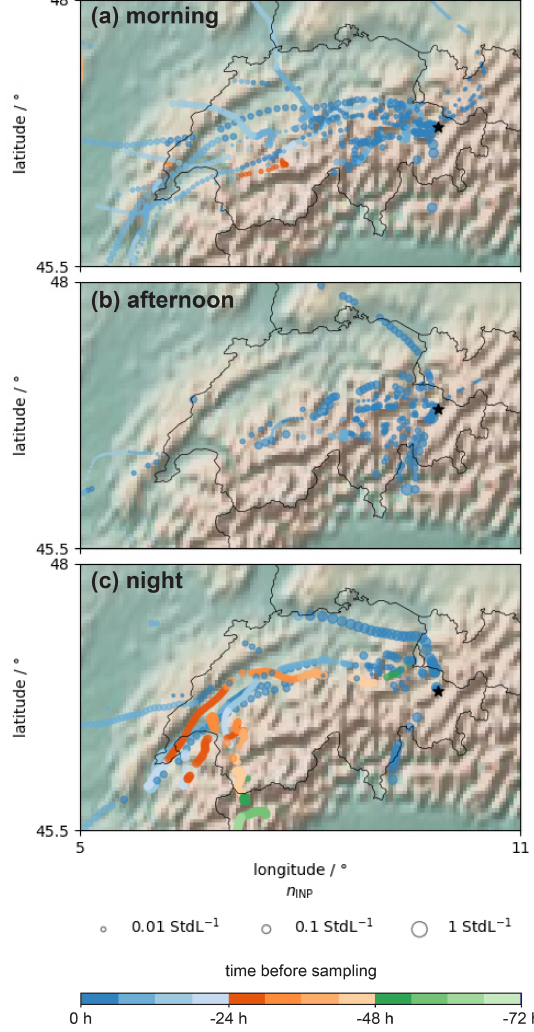
Figure 9. Footprint maps of potential INP uptake locations derived from back-trajectories associated with INP samples (one trajectory per sample) taken at WFJ for the periods in the morning (a) , after- noon (b) , and at night (c) . The circles indicate locations where a trajectory’s 10min time step was lower than 500m above ground (and the surface height less than 2500ma . s . l . ). The color of a circle indicates the time before the corresponding air mass was sampled at WFJ. The size of a circle is proportional to the INP concentration at − 12 ◦ C measured at WFJ. The black star indicates the location of WFJ. The shaded relief was plotted with the Python basemap